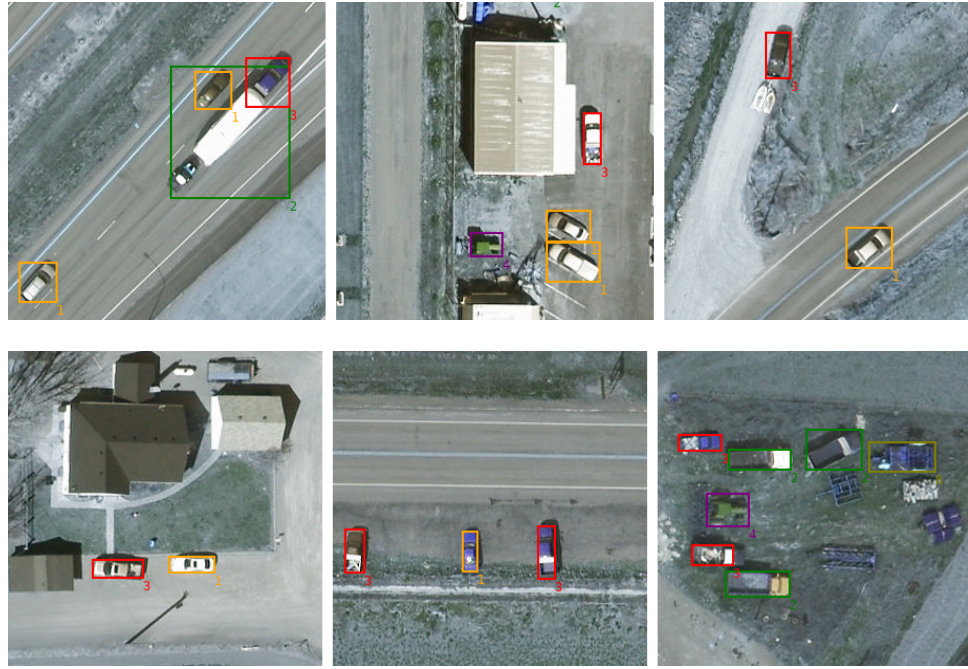
Figure 1. Vehicle detection from the VEDAI’s aerial images performed by the proposed contrastive mutual guidance loss. Class labels include car (1), truck (2), pickup (3), tractor (4), camping (5), boat (6), van (7), other